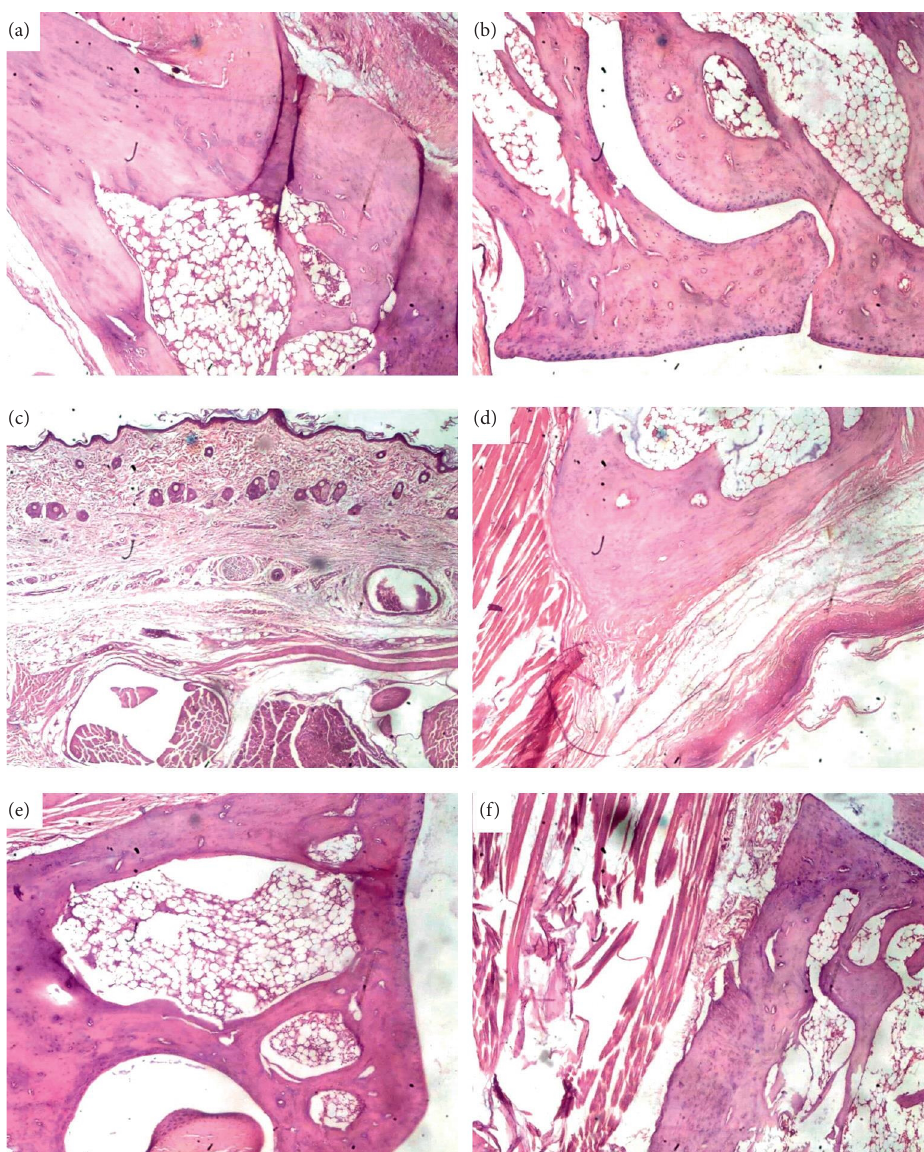
Figure 5: Photomicrographs from the joints of rats pretreated with IFA (a), CFA (b), dexamethasone (c), 30 mgkg − 1 of PSRE (d), 100mgkg − 1 of PSRE (e) and 300mg kg − 1 of PSRE (f) in adjuvant-induced